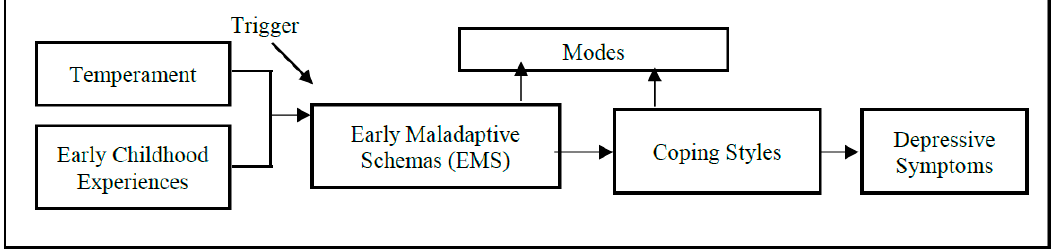
Figure 1. Pictorial Representation of the Schema Model [14]. This has been simplified to exclude other potential direct and indirect relationships between variables.